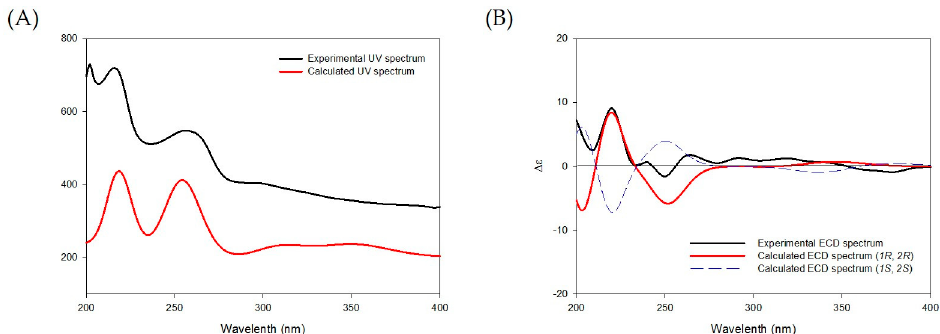
Figure 2. Key 1 H- 1 H COSY ( ▬ ) and 1 H- 13 C-HMBC-( → ) correlations of 1 and 2 .